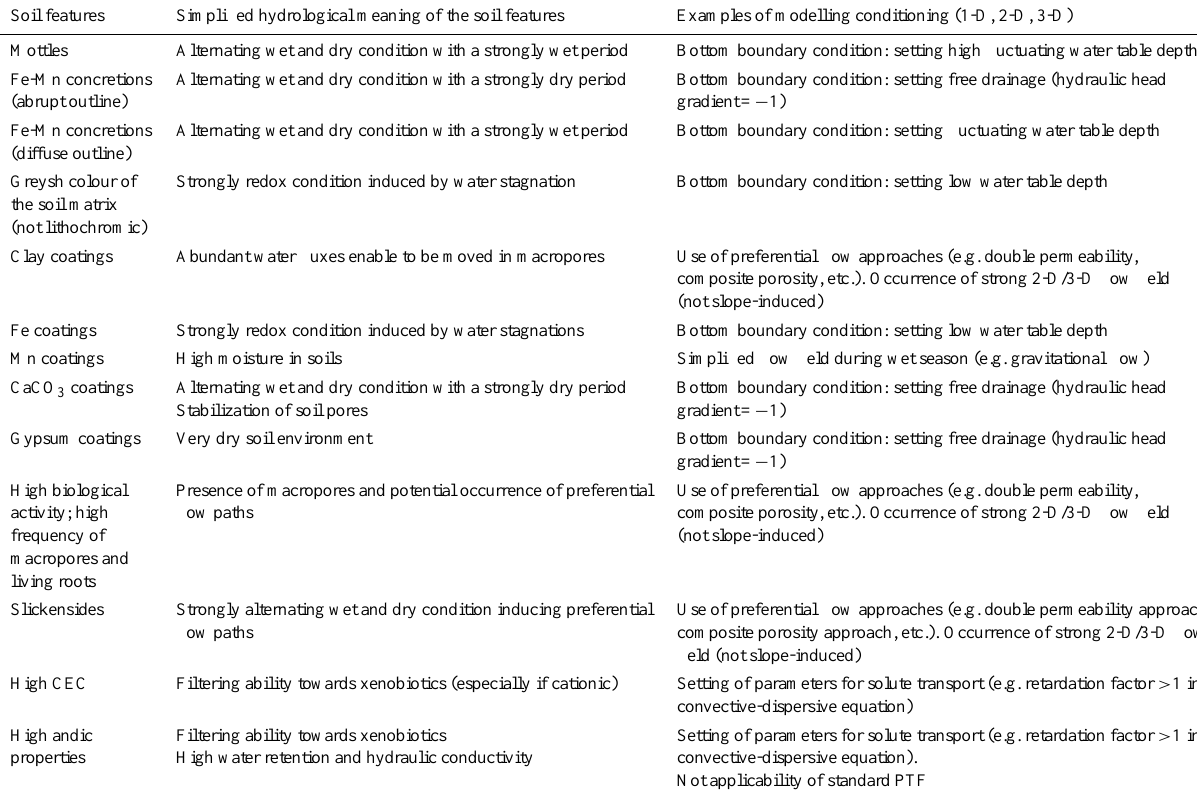
Table 4a. Indirectly usable soil features commonly occurring in databases and exploitable in hydrological modelling. Soil features